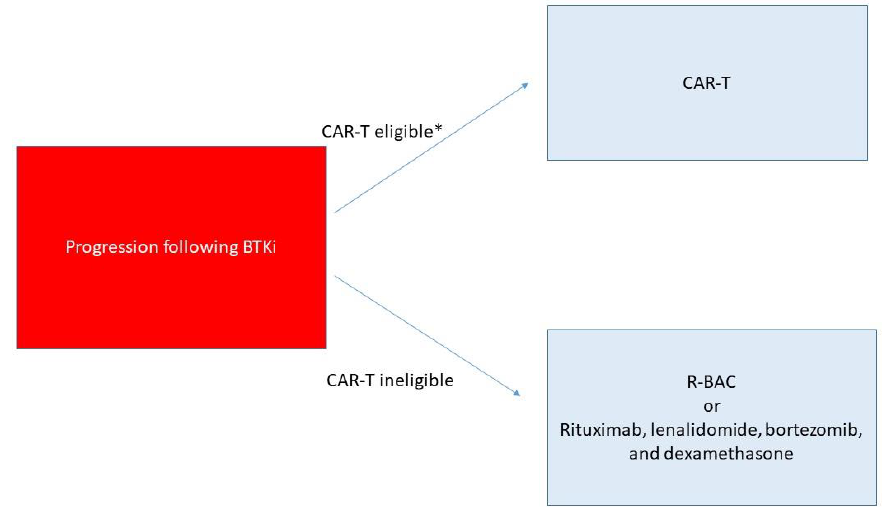
Figure 2. Author’s Approach to Management of Relapsed/Refractory Mantle Cell Lymphoma Following BTK inhibitor Treatment. BTKi—acalabrutinib, ibrutinib, or zanubrutinib, CAR-T- chimeric antigen receptor T cell therapy, brexucab-